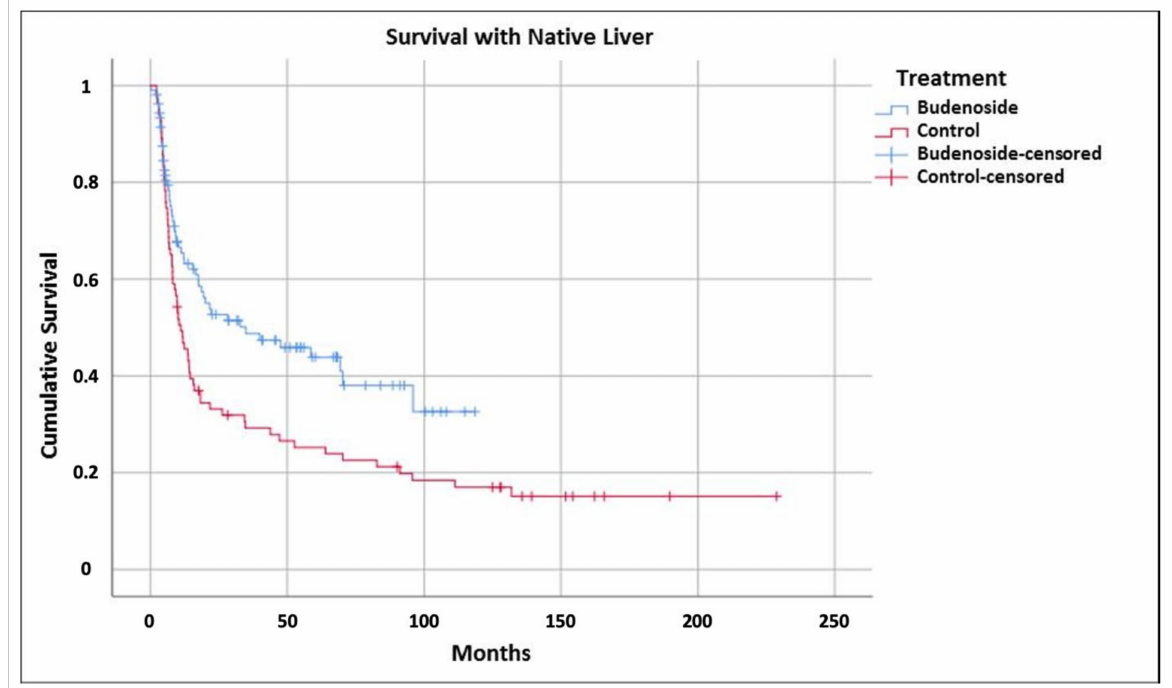
Figure 1. After two years, survival with native liver was 54% in the study and 32% in the control group ( p <